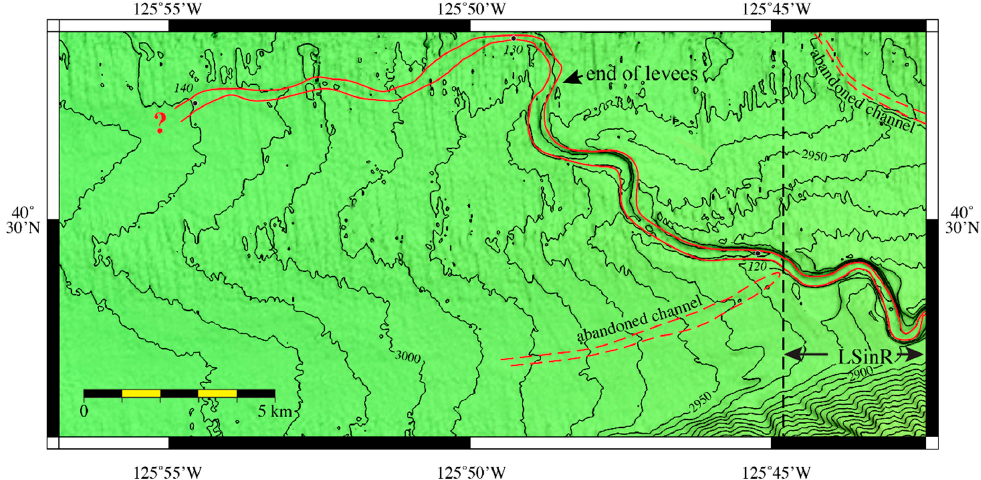
Figure 14. Map view of multibeam bathymetry of the western end of the lower straight reach (LSR) and the western-most lower sinuous reach (LSinR). LSR outlined in red. Ten km black circles mark distances in km in italics from the junction of Mendocino and Mattole Canyons. Red dashed lines outline two abandoned channels. The end of levees on either side of Mendocino Channel indicated with a black arrowhead. Isobath interval 10 m. See Figure 2 for location.